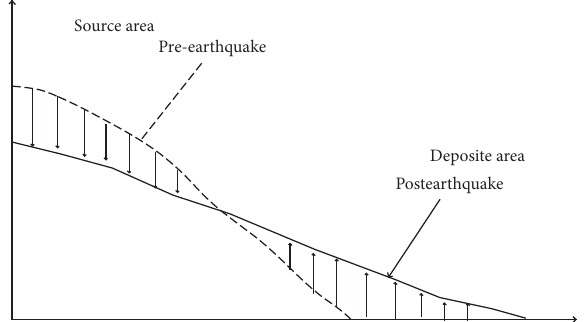
Figure 2: Sketch showing the elevation change of slope after seismic